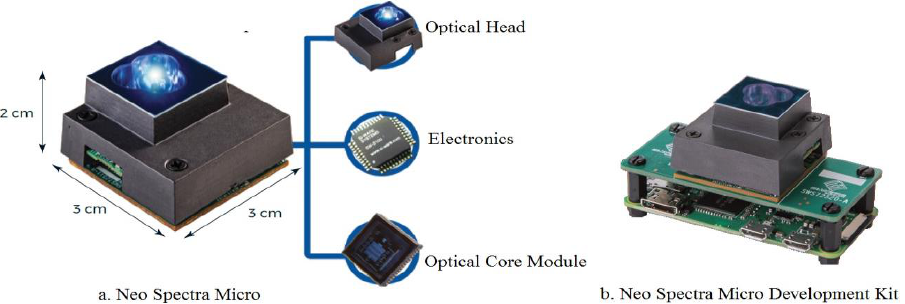
Figure 1. Portable NIR spectroscopy components (www.neospectra.com, accessed on 20 August 2022).